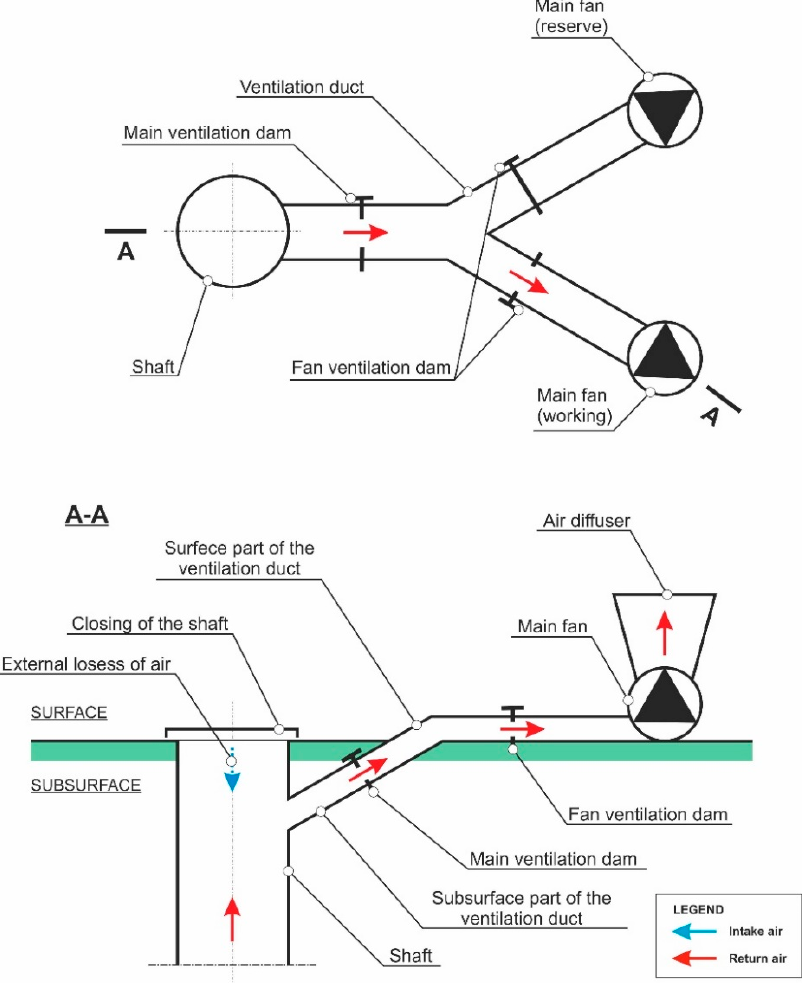
Figure 6. Diagram regarding a typical solution of the ventilation ducts at the main ventilation sta-